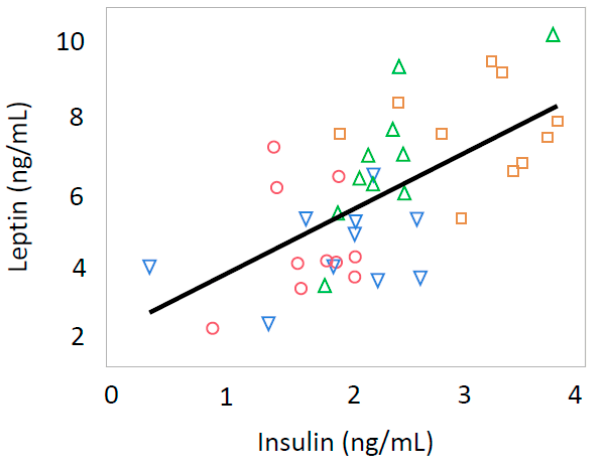
Figure 5. Relationship between serum leptin levels and serum insulin levels in both male and female rat offspring (R = 0.627, p < 0.0001). Green triangle, male offspring from control group; square, male offspring from Ca-deficient group; circle, female offspring from control group; blue inverse triangle, female offspring from Ca-deficient group.